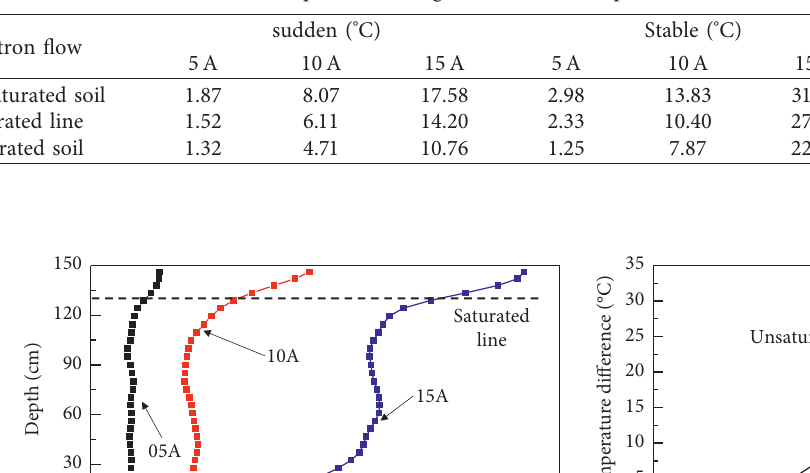
Figure 6: Distribution of temperature difference along height: (a) 10A; (b) 15A. Table 2: Relationship between surge value, stable temperature difference, and heating electron flow.